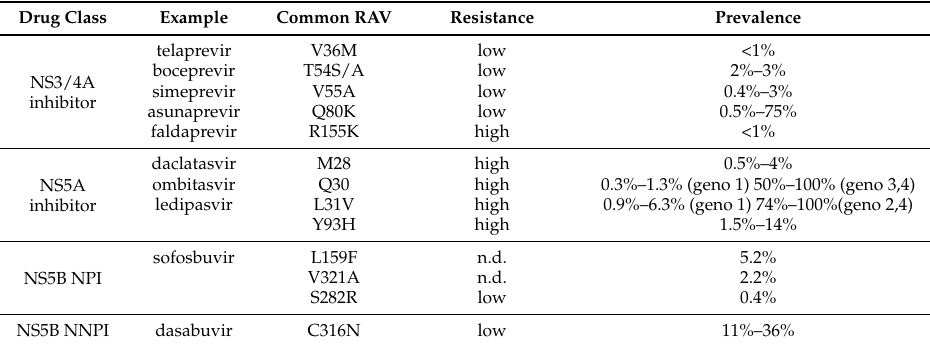
Table 1. Common RAVs; resistance and